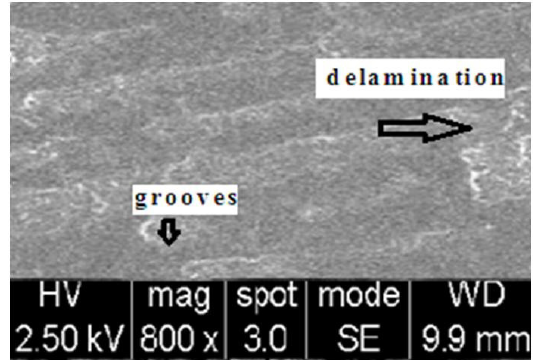
Figure 14. Surface of the material after